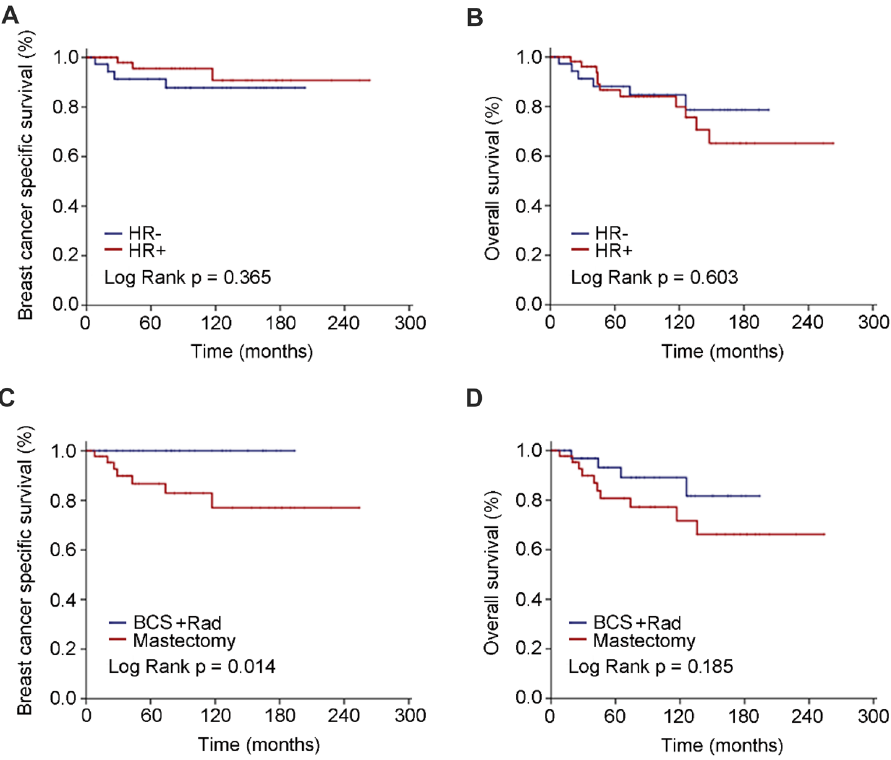
Figure 3. Survival outcomes categorized by hormone receptor and surgery modalities. ( A ) Kaplan and Meier estimates of BCSS (breast cancer specific survival) grouped by HR (hormone receptor) status. ( B ) Kaplan and Meier estimates of OS (overall survival) grouped by HR status. ( C ) Kaplan and Meier estimates of BCSS grouped by BCS (breast conserving surgery) and radiotherapy and mastectomy. ( D ) Kaplan and Meier estimates of OS grouped by BCS and radiotherapy and